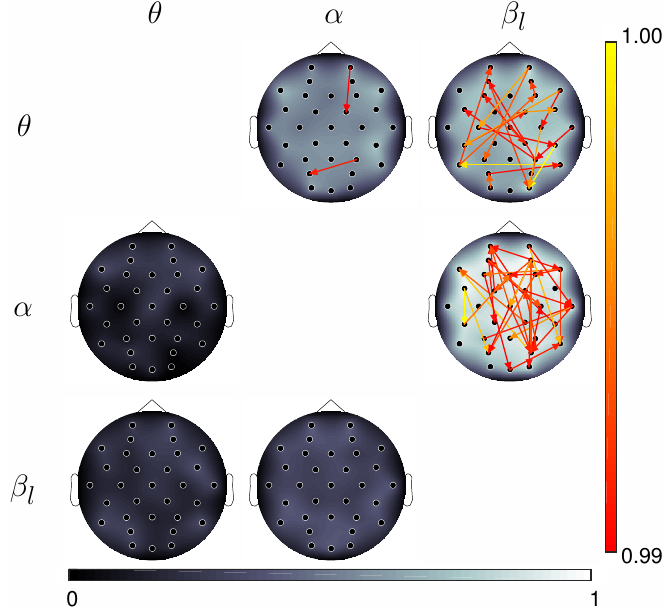
Figure 8. Topoplots of the average nodal (channel) relevance for each tested frequency band pair. The arrows represent the most relevant connections. For visualization purposes, only the connections with the highest average relevance values are depicted (1% of all connections). The rows indicate the frequency band driving the phase-amplitude interactions, while the columns correspond to the frequency band of the driven oscillations (e.g., the topoplot in the top right corner shows the nodal relevance and relevant connections obtained when TE θθ ς κα was computed, assuming directed interactions from the oscillations phases in the θ band to the amplitude envelope of oscillations in the β l